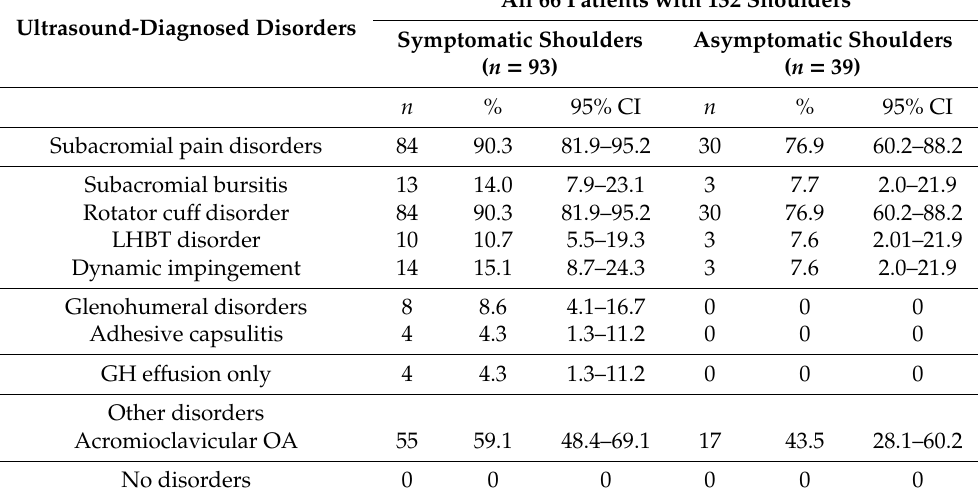
Table 2. Ultrasound-diagnosed disorders in symptomatic and asymptomatic shoulders in patients with T2DM ( n =